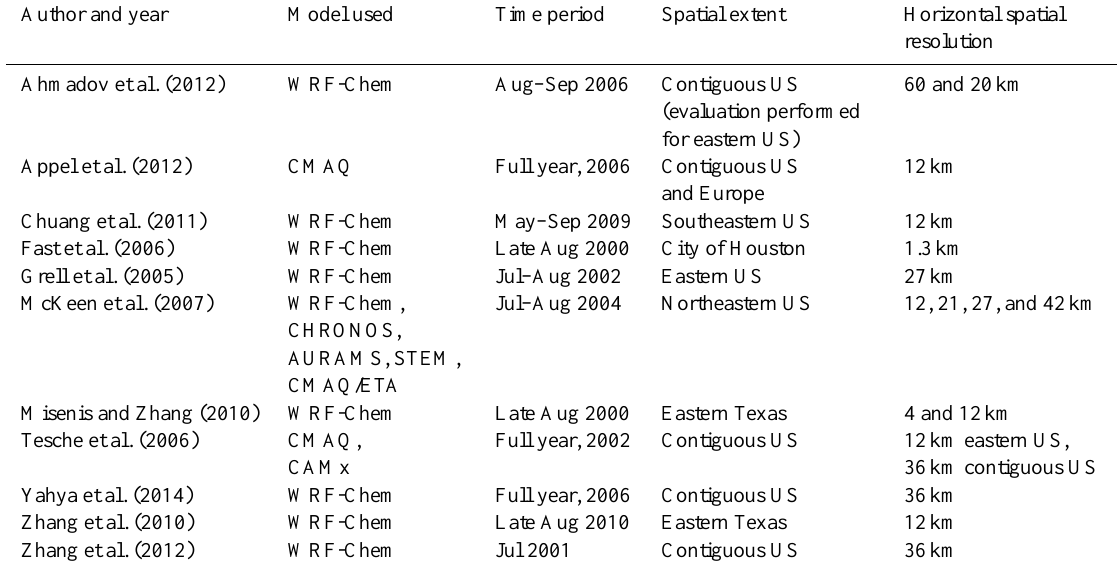
Table A1. Temporal and spatial aspects of recent model evaluations, focusing on WRF-Chem and North America. Author and year Model used